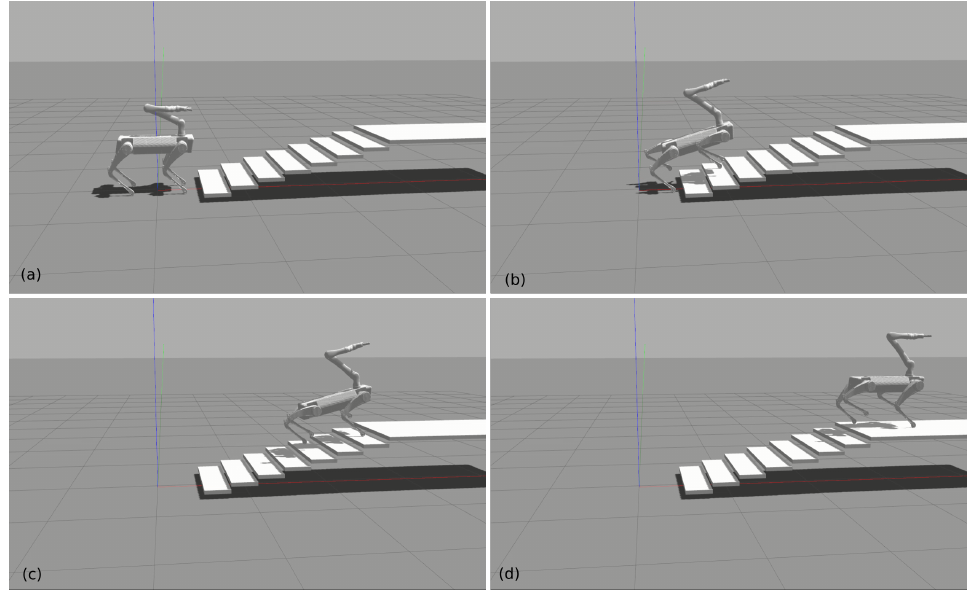
Figure 8. Trotting up stairs while moving the arm. ( a ) The initial position. ( b ) Trotting upstairs. ( c ) Trotting upstairs further. ( d ) Trotting to the